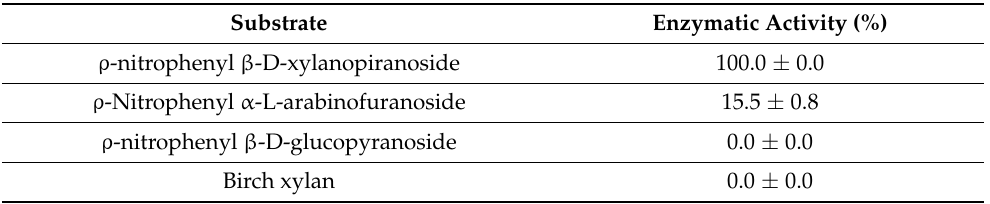
Table 2. Activity of β -xylosidase SRBX1 from S. reilianum against different substrates.